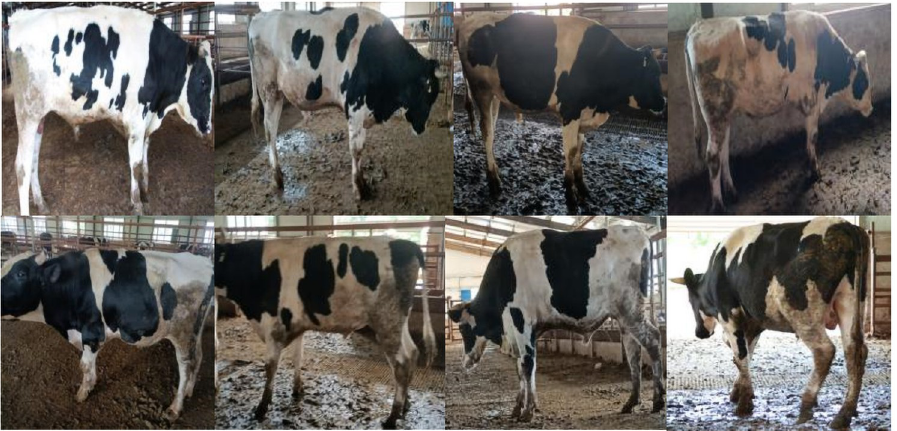
Fig 1. Examples of individual cow